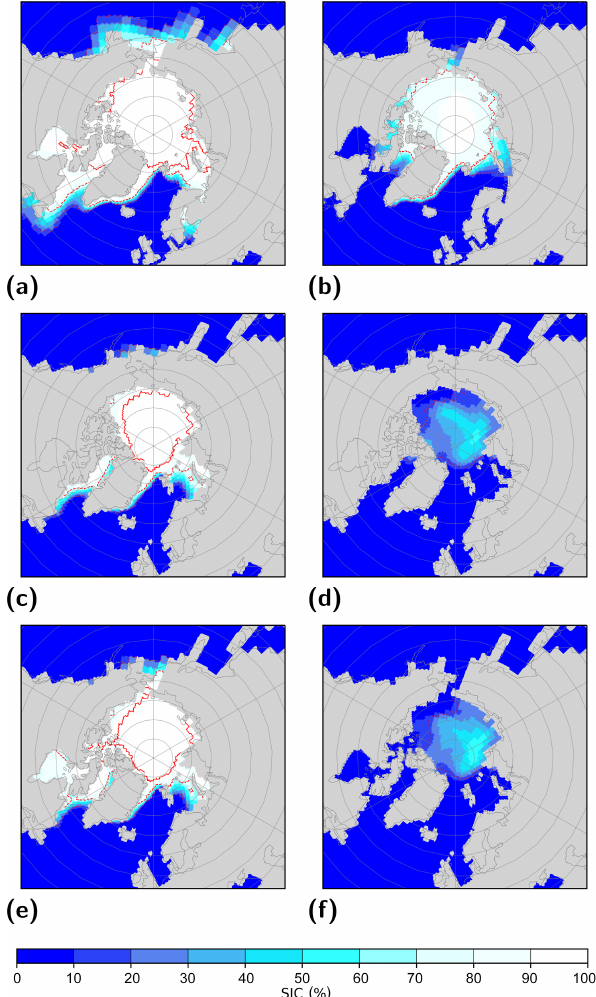
Figure 5. Sea ice coverage (SIC) in the Northern Hemisphere for boreal spring (MAM, a, c, e ) and boreal autumn (SON, b, d, f ). Shown are (a, b) E280 (pre-industrial), (c, d) Eoi400 (PlioMIP2 mid-Pliocene core simulation), and (e, f) Eoi400_GW (as Eoi400, but with modern Bering Strait, Hudson Bay, and Canadian Arctic Archipelago). Grey shading illustrates the land–sea mask. Red con- tours illustrate SIC isolines of 15% (dotted), 75% (dashed), and 95%